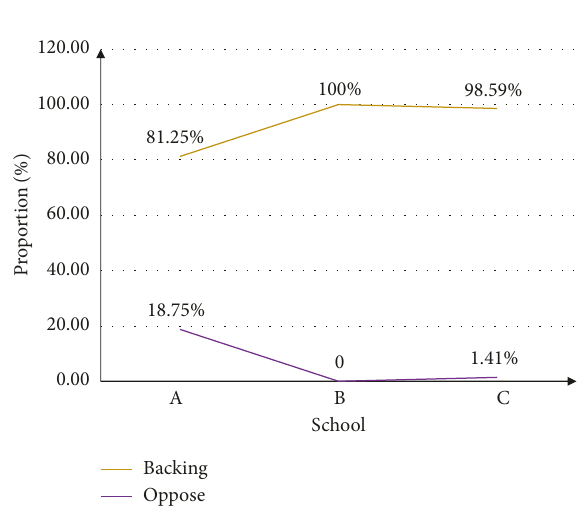
Figure 8: Whether students majoring in physical education support the promotion of new sports